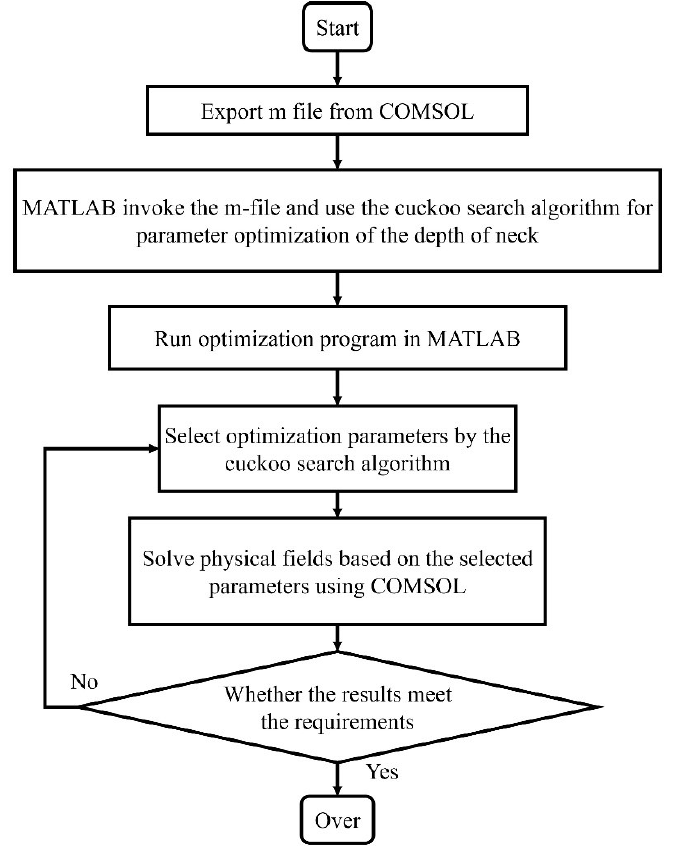
Figure 6. The process of the joint simulation platform for algorithm and physical field simulation.